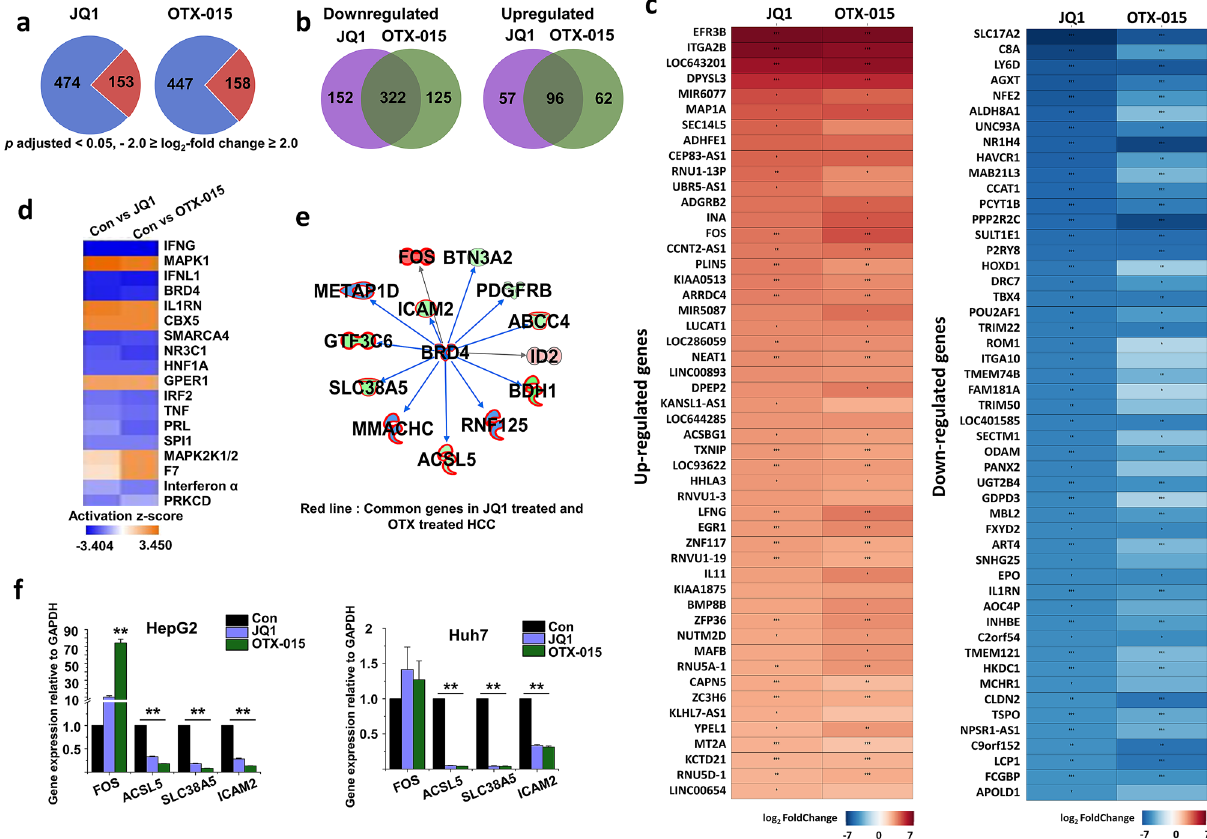
Figure 2. Differential gene expression in BET inhibitor-treated HCC cells and comparison of JQ1-inducible and OTX-inducible transcriptional datasets. ( a ) Pie chart displaying the number of up- and downregulated genes of BET inhibitor-treated HCC cells. Blue indicates downregulation, and red indicates upregulation. ( b ) The overlap area indicates the number of shared up- and downregulated genes in JQ1- and OTX-015-treated HepG2 cells. ( c ) A heat map representing the top 50 up- and downregulated genes in BET inhibitor-treated HepG2 cells ( p adjusted < 0.05, log 2 -fold change ≥ 2, log 2 -fold change ≤ − 2). The color scale shown in the heat map represents the log2 fold change values. Red color indicates upregulated genes while blue color indicates downregulated genes. The heat map was created in R using the ggplot2 package version 3.3.3 (URL: https:// ggplo t2. tidyv erse. org) 69 . The p value with an asterisk attached in the cell represents * p < 0.05, ** p < 0.01, and *** p < 0.001. ( d ) Upstream regulator analysis of alternated gene datasets in Con vs. JQ1-treated HCC and Con vs. OTX-015-treated HCC cells using Ingenuity pathway analysis (IPA; https:// www. quiag enbio infor matics. com/ produ cts/ ingen uity- pathw ay- analy sis). ( e ) The activity of highly connected negative regulators of BRD4, a member of the BET family of proteins, led to this network’s inactivation, as assessed using the IPA molecule activity predictor in BET inhibitor-treated HCC cells. The red line indicates common genes in JQ1- and OTX- 015-treated HepG2 cells. ( f ) Confirmation of differentially expressed genes by qPCR in BET inhibitor-treated HCC cells compared with DMSO-treated HCC cells. The values are the mean ± S.D. of triplicate wells. ** p <